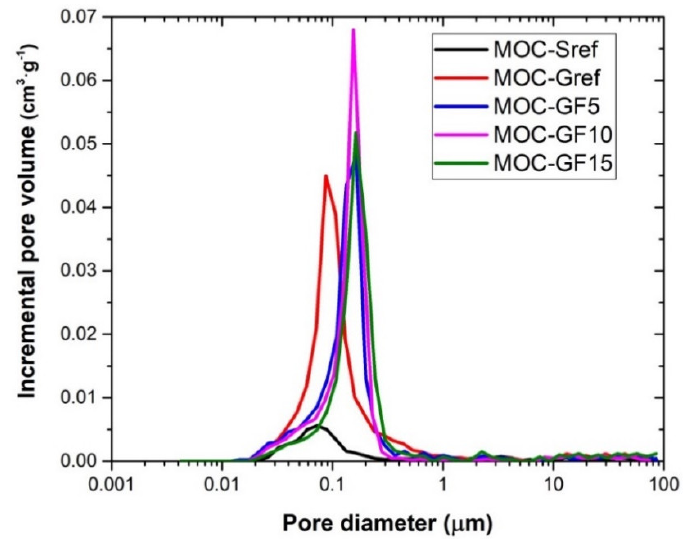
Figure 6. MIP incremental pore volume curves.